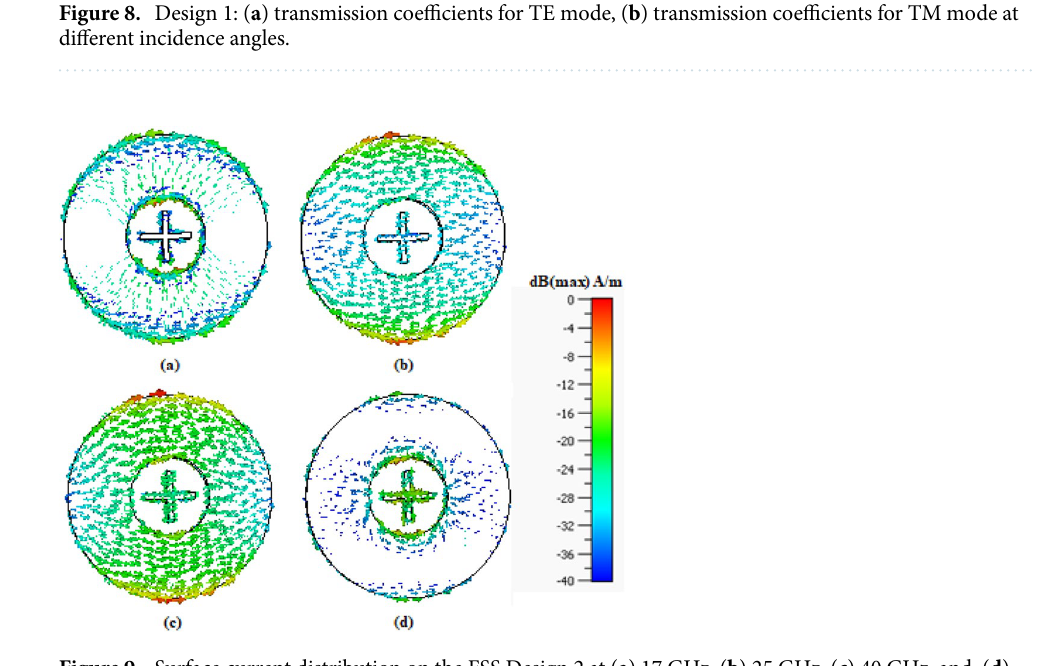
Figure 9. Surface current distribution on the FSS Design 2 at ( a ) 17 GHz, ( b ) 25 GHz, ( c ) 40 GHz, and ( d ) 58